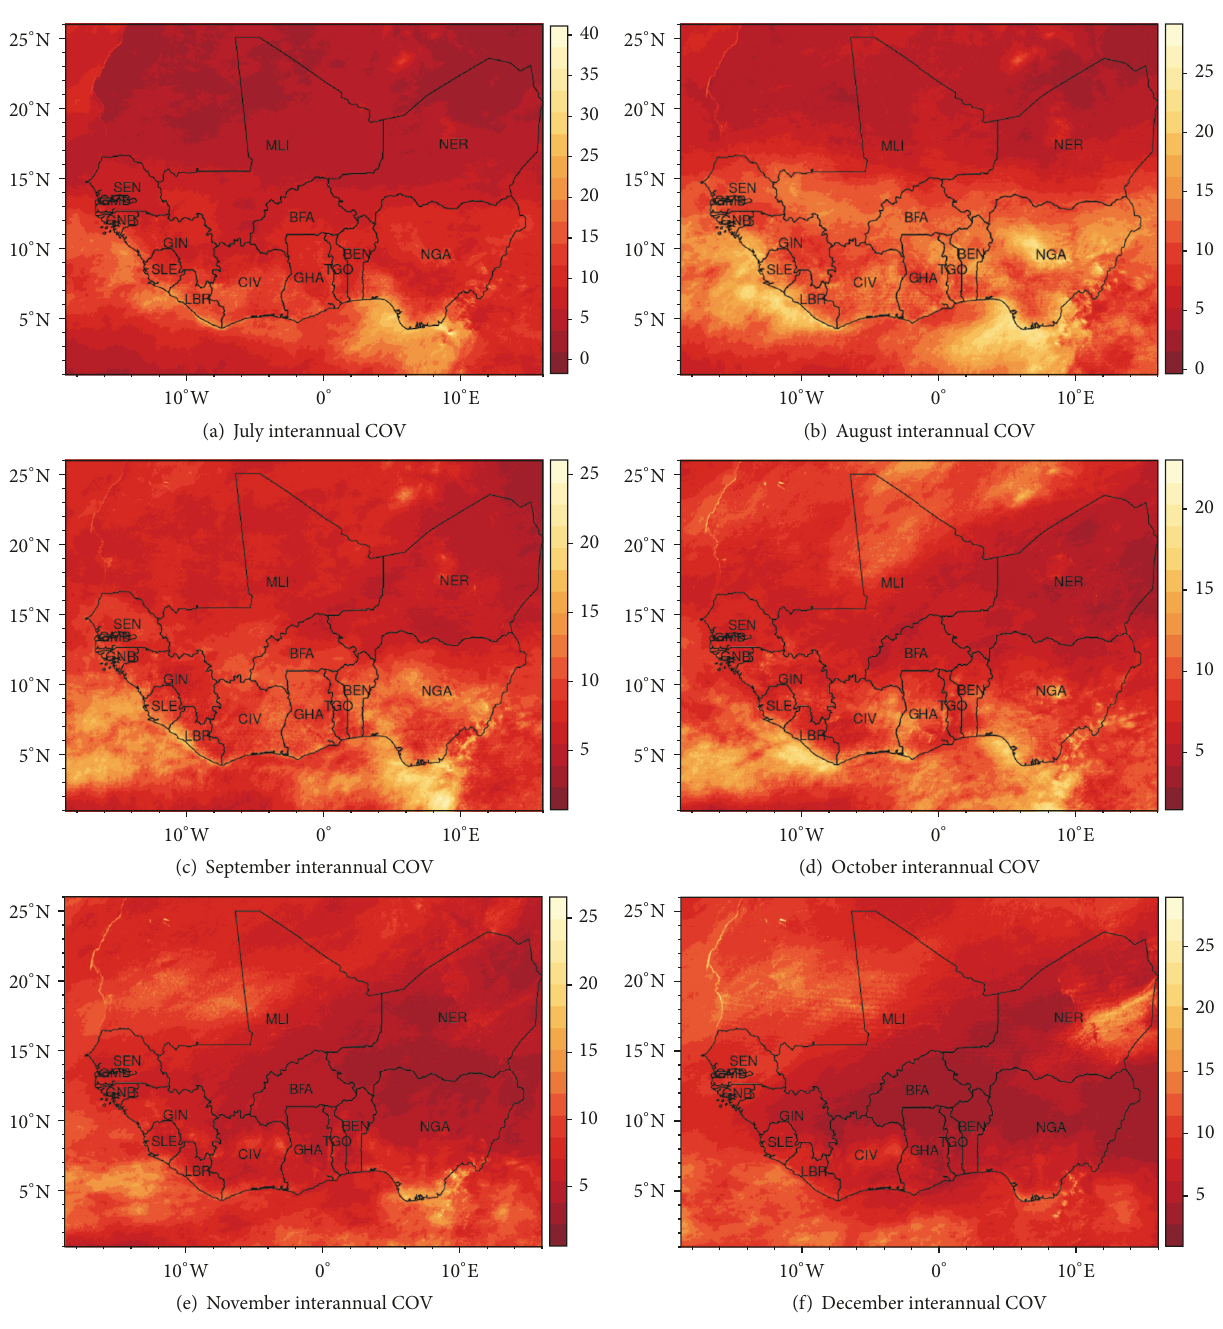
Figure 4: Monthly solar resources coefficient of variation